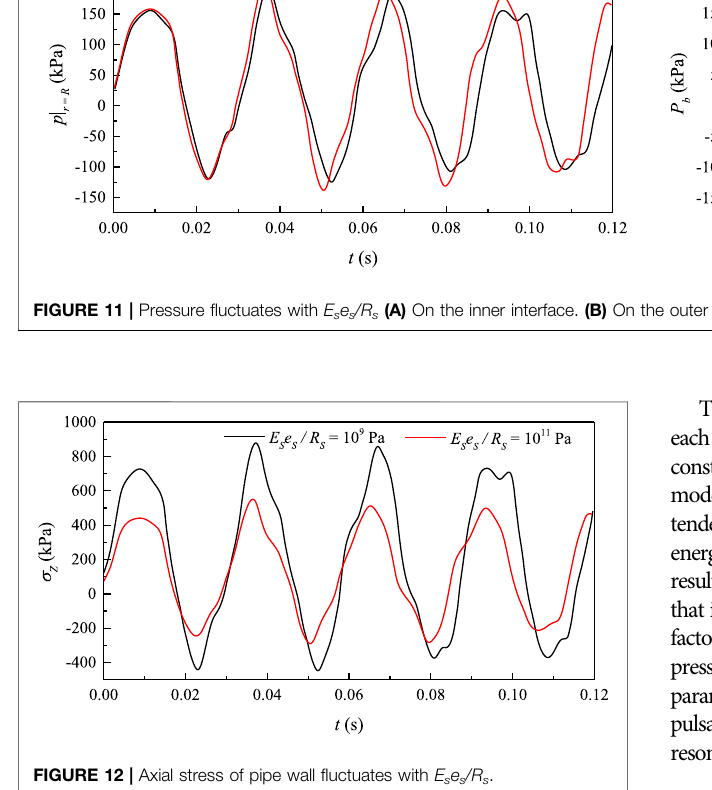
with respect to different models are shown in Table 1 . Data in the right column correspond to the local peaks in Figure 14B . is 35.2 Hz, the frequency of stress wave in pipe wall is 129.3 Hz, and the frequency of stress wave in concrete is 99.6 Hz.